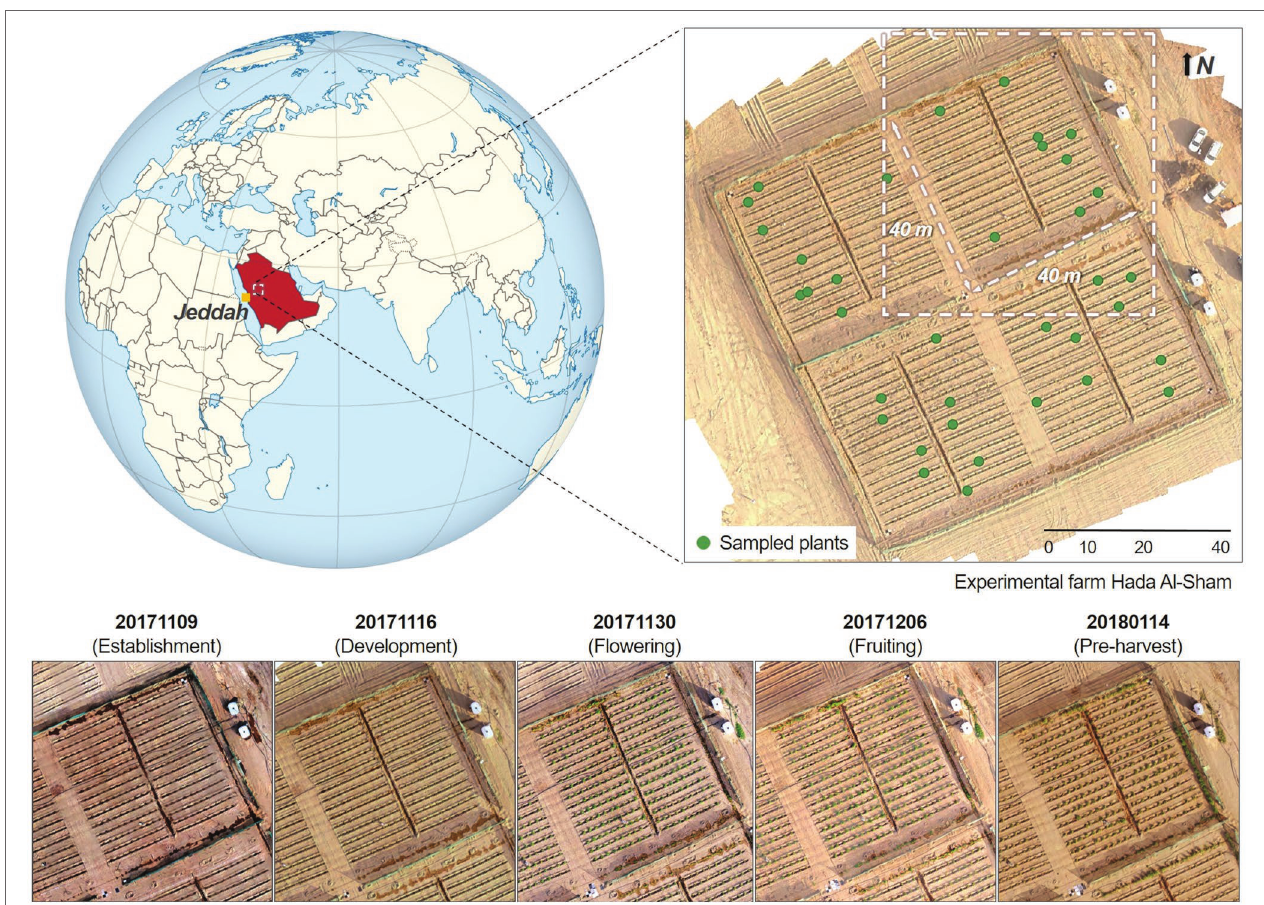
FIGURE 1 | Temporal maps of the studied quadrant at the Hada Al-Sham experimental facility (Lat. = 21.797 ° , Long. = 39.725 ° ), where a wild tomato species was cultivated. Five different collections were performed between November 2017 and January 2018. The globe map is part of a series of SVG locator maps of countries including elements that have been adapted from the file: Afro-Eurasia on the globe (red).svg, and distributed under CC-BY-SA-3.0